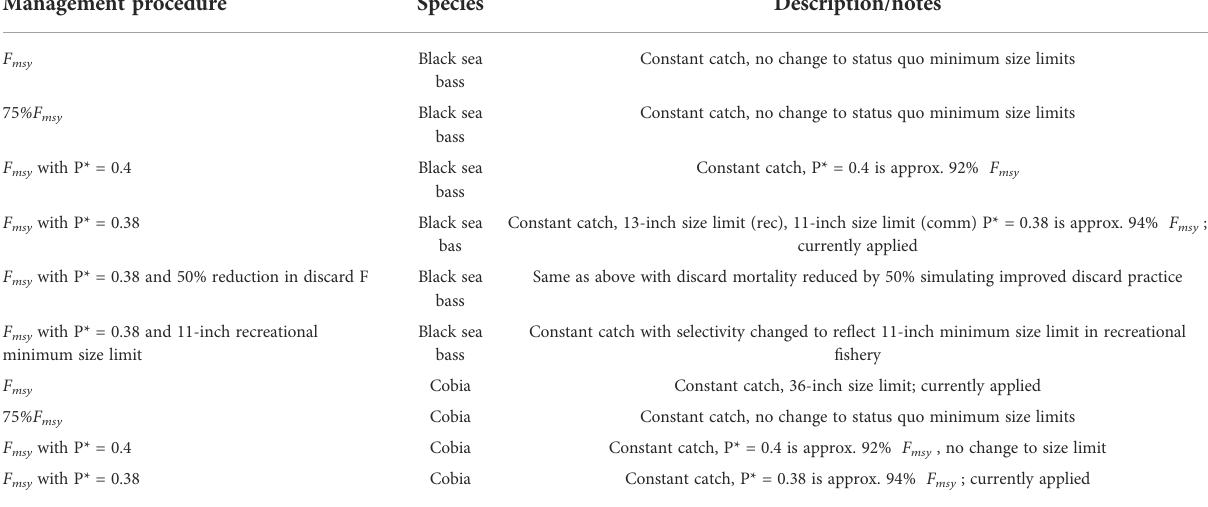
TABLE 4 Management procedures by species: black sea bass (BSB) and cobia (COB). Management